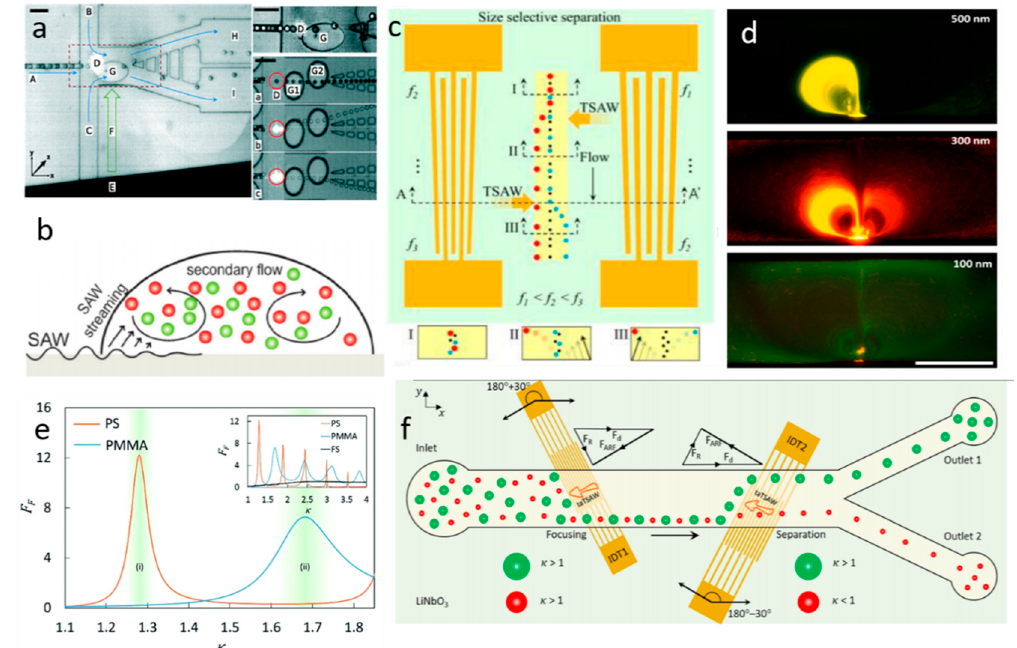
Figure 3. ( a ) TSAW-induced acoustic streaming selectively deflects droplets with fluorescent signal. Reprinted with permission from reference [60]. ( b ) Density-based separation by TSAW-induced acoustic streaming. With TSAW actuation, the lighter particles are distributed at the periphery and more dense particles are accumulated in the center. Reprinted with permission from reference [61]. ( c ) Using two IDTs with di ff erent frequencies, mixtures of three sizes of particles are separated by TSAW-induced acoustic radiation force. Reprinted with permission from reference [63]. ( d ) Sub-micron particles separation by TSAW. 500 nm and 300 nm particles are trapped by TSAW-induced radiation force, while 100 nm particles are not trapped due to the stronger drag force. Reprinted with permission from reference [65]. ( e ) Di ff erent acoustic radiation force for same-sized particles. Reprinted with permission from reference [64]. ( f ) Tilted-angled TSAW (TaTSAW)-induced radiation force for particle focusing and particle separation. Reprinted with permission from reference [66]. SAW—surface acoustic